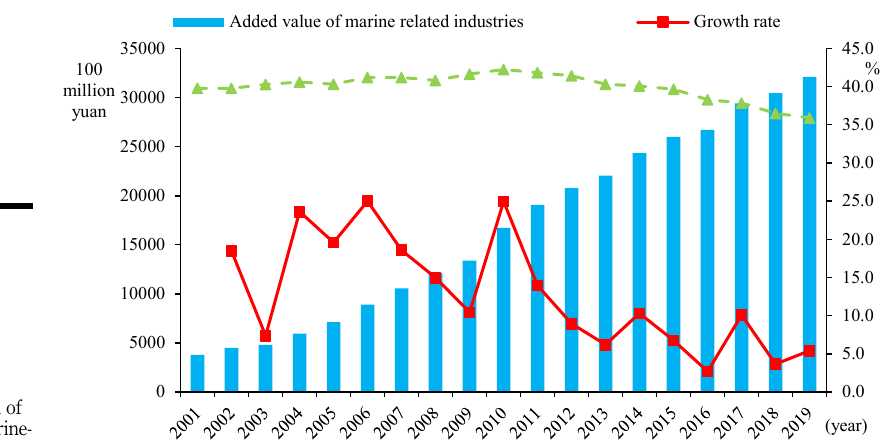
Figure 4. Development trend